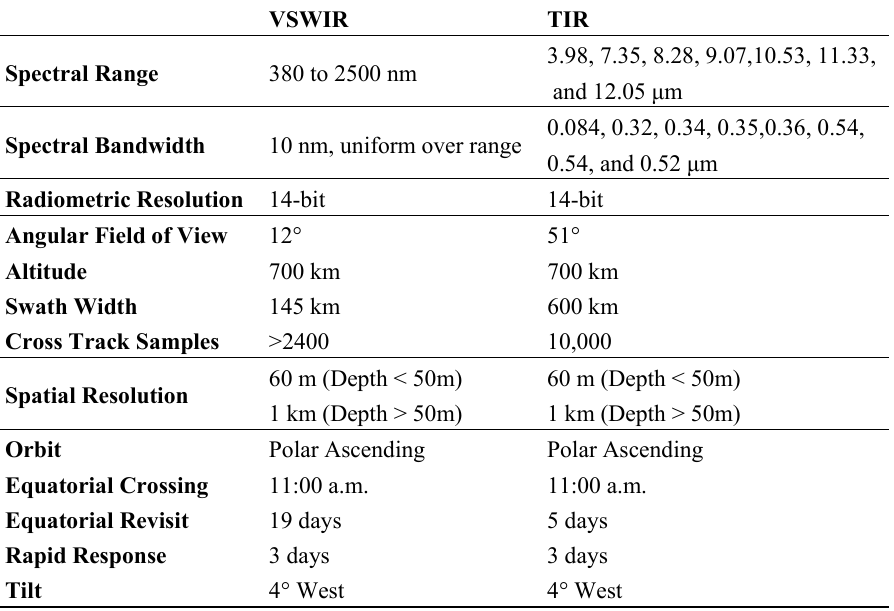
Table 1. Key characteristics of the Hyperspectral Infrared Imager (HyspIRI)